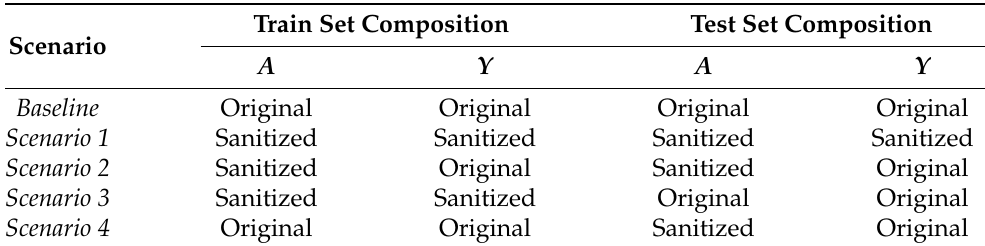
Table 4. Scenarios envisioned for the evaluation of GANSan . Each set is composed of either the original attributes or their sanitized versions, coupled with either the original or sanitized decision. Train Set Composition Test Set Scenario